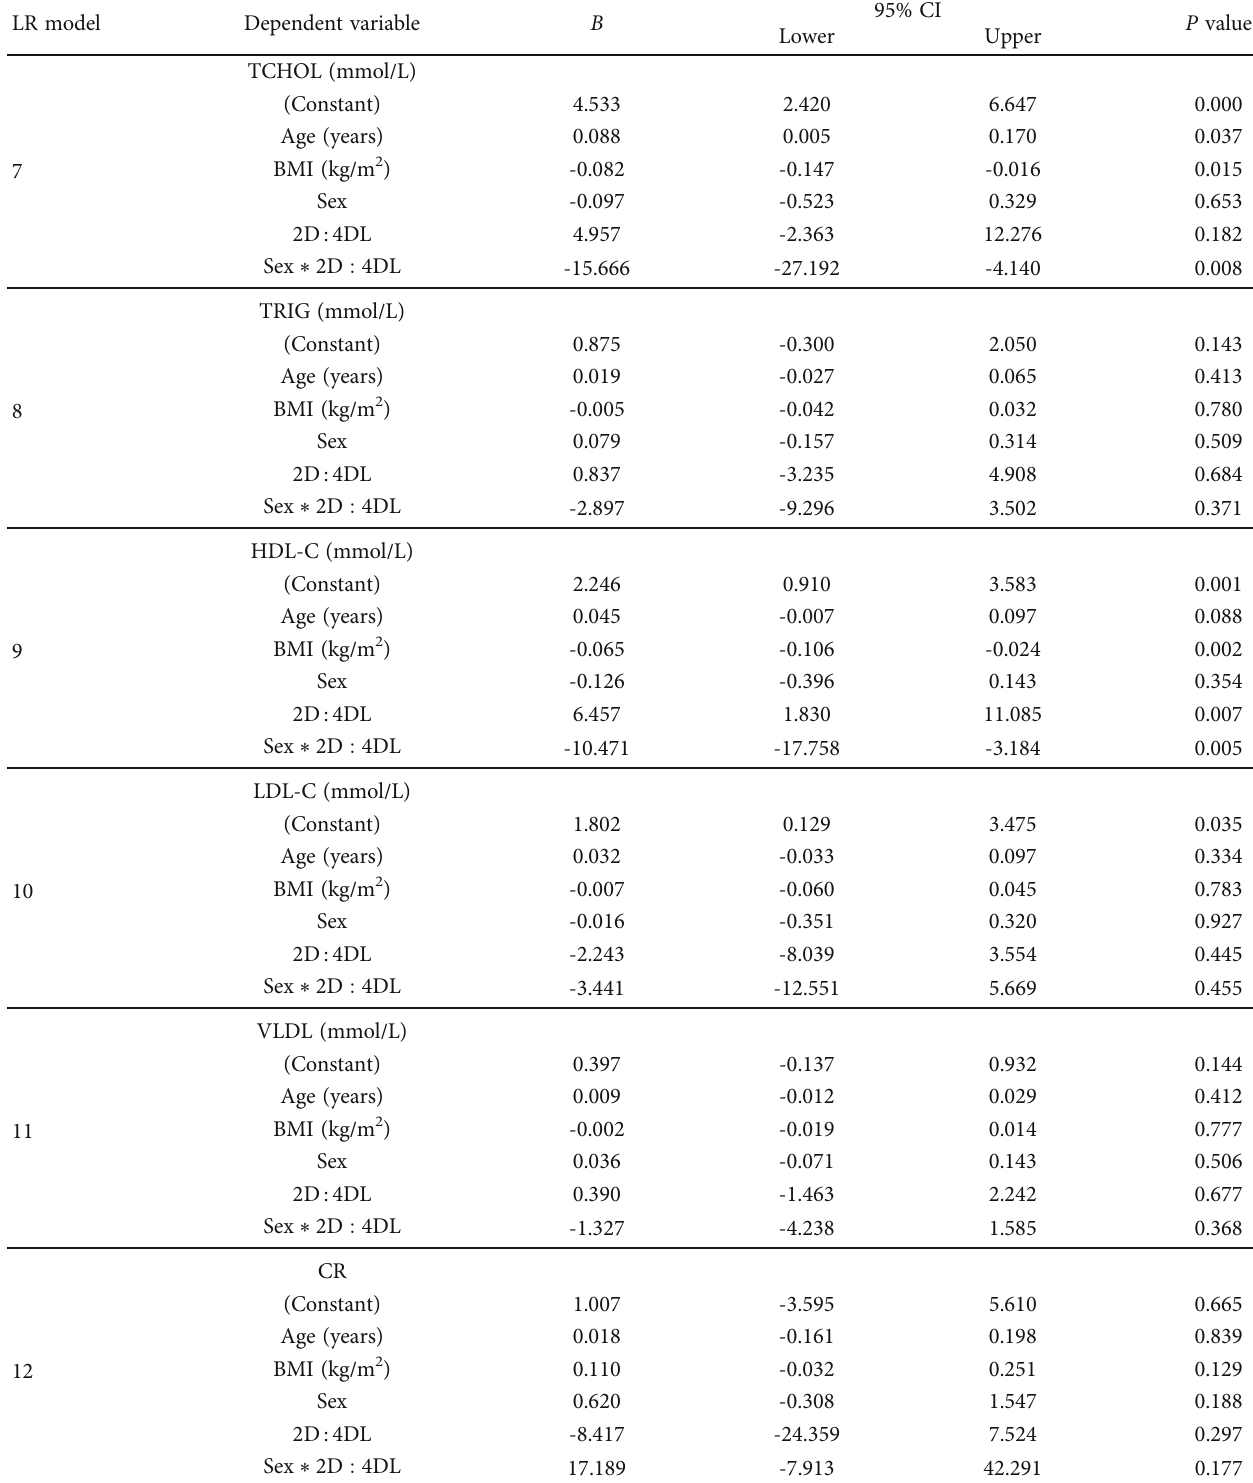
Table 3: Interactions between sex and the 2D: 4DL on fasting plasma lipid